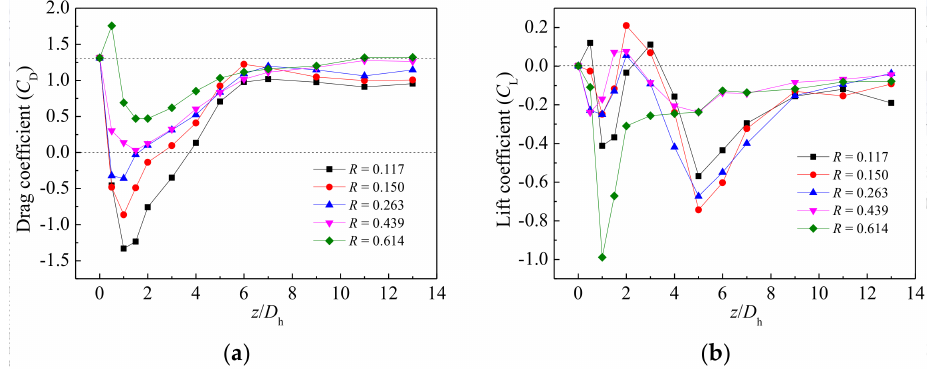
Figure 17. Drag coefficients ( a ) and lift coefficients ( b ) at different R without vanes.